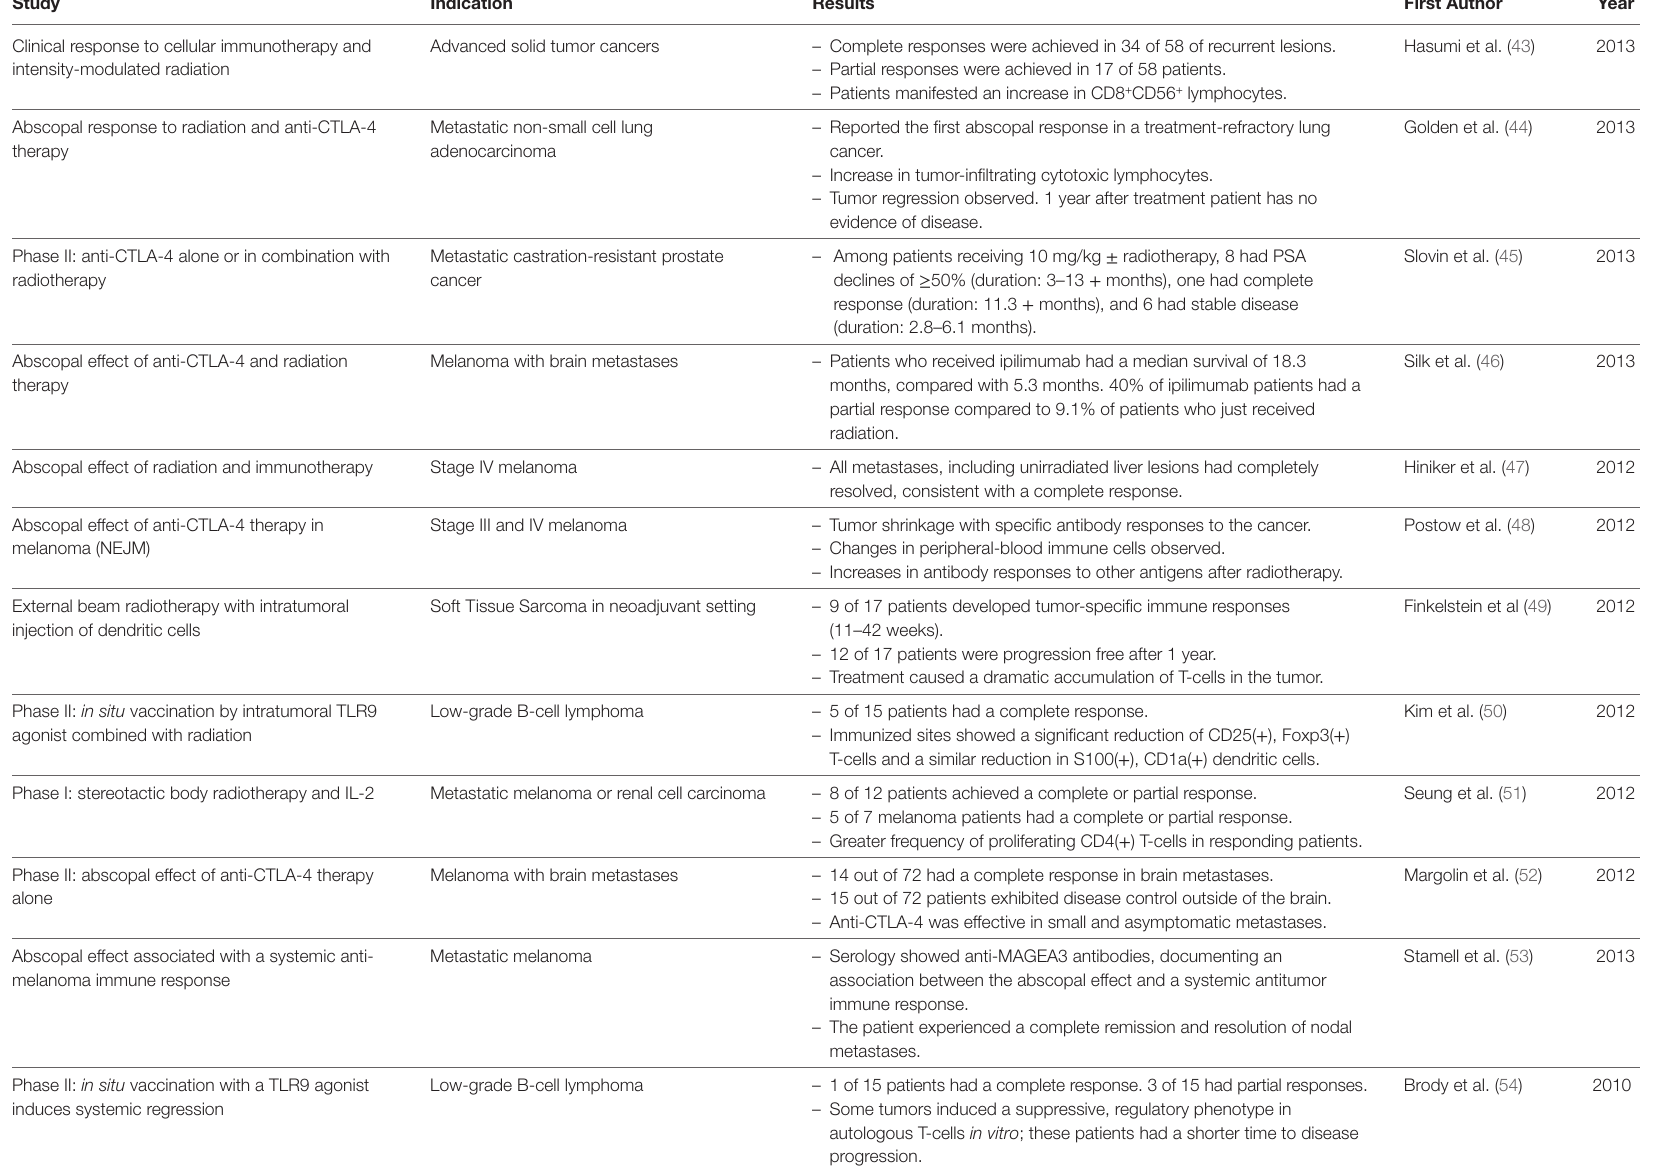
TABLe 2 | Clinical trials that have yielded robust abscopal